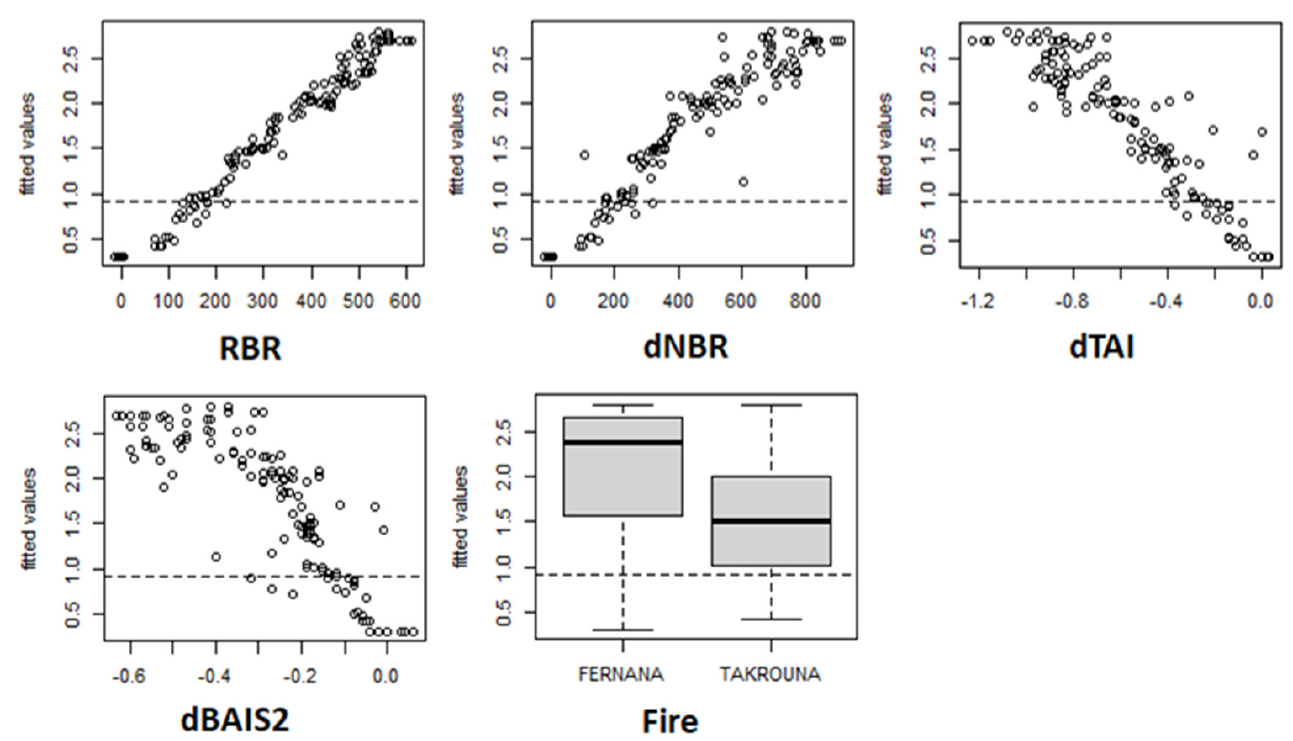
Figure 7. Raw correlations between the CBI and the spectral severity indices (RBR, dNBR, dTAI, and dBAIS2) and the fire at which the sampling points belonged in the boosted regression trees (BRT).